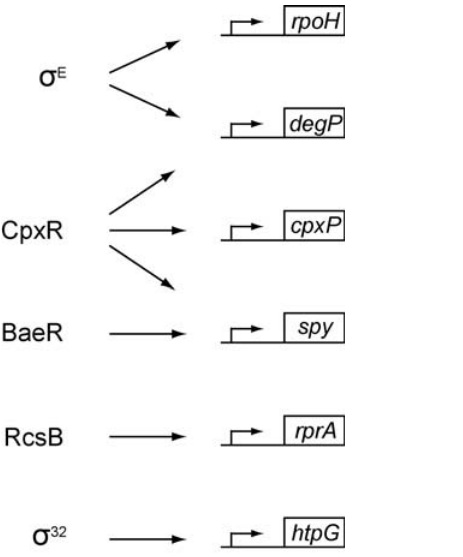
Figure 3. Diagram of stress regulators and their respective regulon members used as reporters in this work. All reporter constructs are present as lacZ fusions integrated as a single-copy in the chromosome. The rpoH P3- lacZ fusion is regulated by s E . The degP - lacZ fusion is regulated by s E and CpxR. The cpxP - lacZ fusion is regulated by CpxR. The spy - lacZ fusion is regulated by CpxR and BaeR. The rprA - lacZ fusion is regulated by RcsB. The htpG - lacZ fusion is regulated by s 32 . s E , Cpx, Bae, and Rcs all monitor envelope stress, while s 32 monitors cytoplasmic stress.